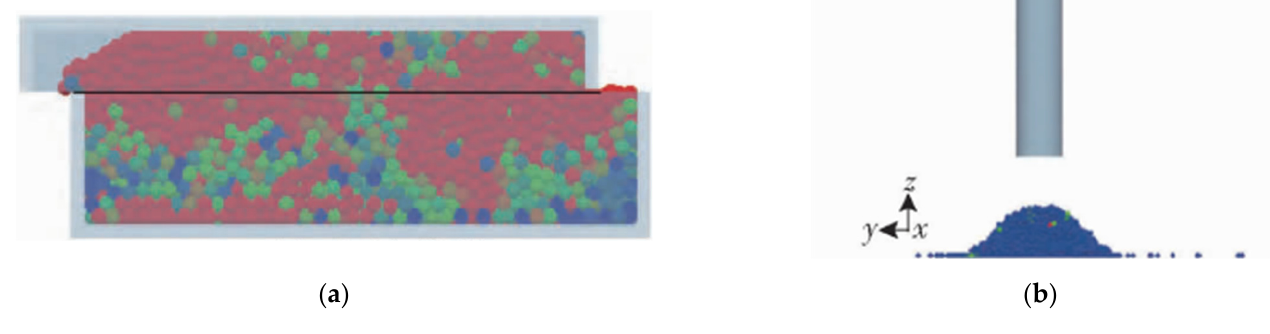
Figure 5. Calibration model. ( a ) Soil self ‐ shear model (time 1.5 s). ( b ) Soil particle calibration accumulation angle (time 3.5 s).